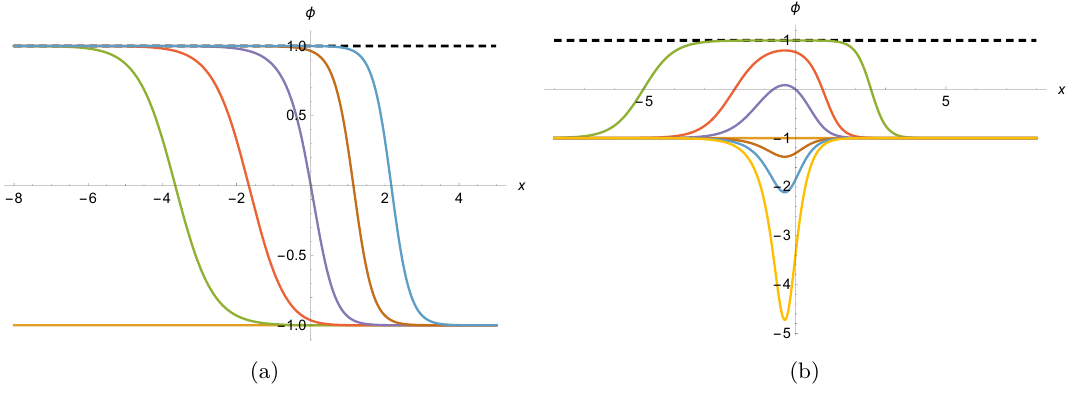
Figure 5 . Supersymmetric solutions of deformed φ 4 theory for g ( x ) in (A.14) with v = a = 1 . (a) g L = 1 and g R = 2 . The vacuum is the dashed straight line φ = 1 with energy E = − 2 / 3 . The other constant solution φ = − 1 has energy E = 2 / 3 . Non-constant solutions are for c = − 4 , − 2 , 0 , 2 and 4, respectively from the left. They all have degenerate energy E vacuum is the dashed straight line φ = 1 with energy E = − 2 . The other constant solution φ = − 1 has energy E = 2 . Non-constant solutions are for c = 4 , 1 , 0 in (A.6), and c = − 1 , − 0 . 6 , − 0 . 3 in (A.8), respectively from the top. They all have degenerate energy E